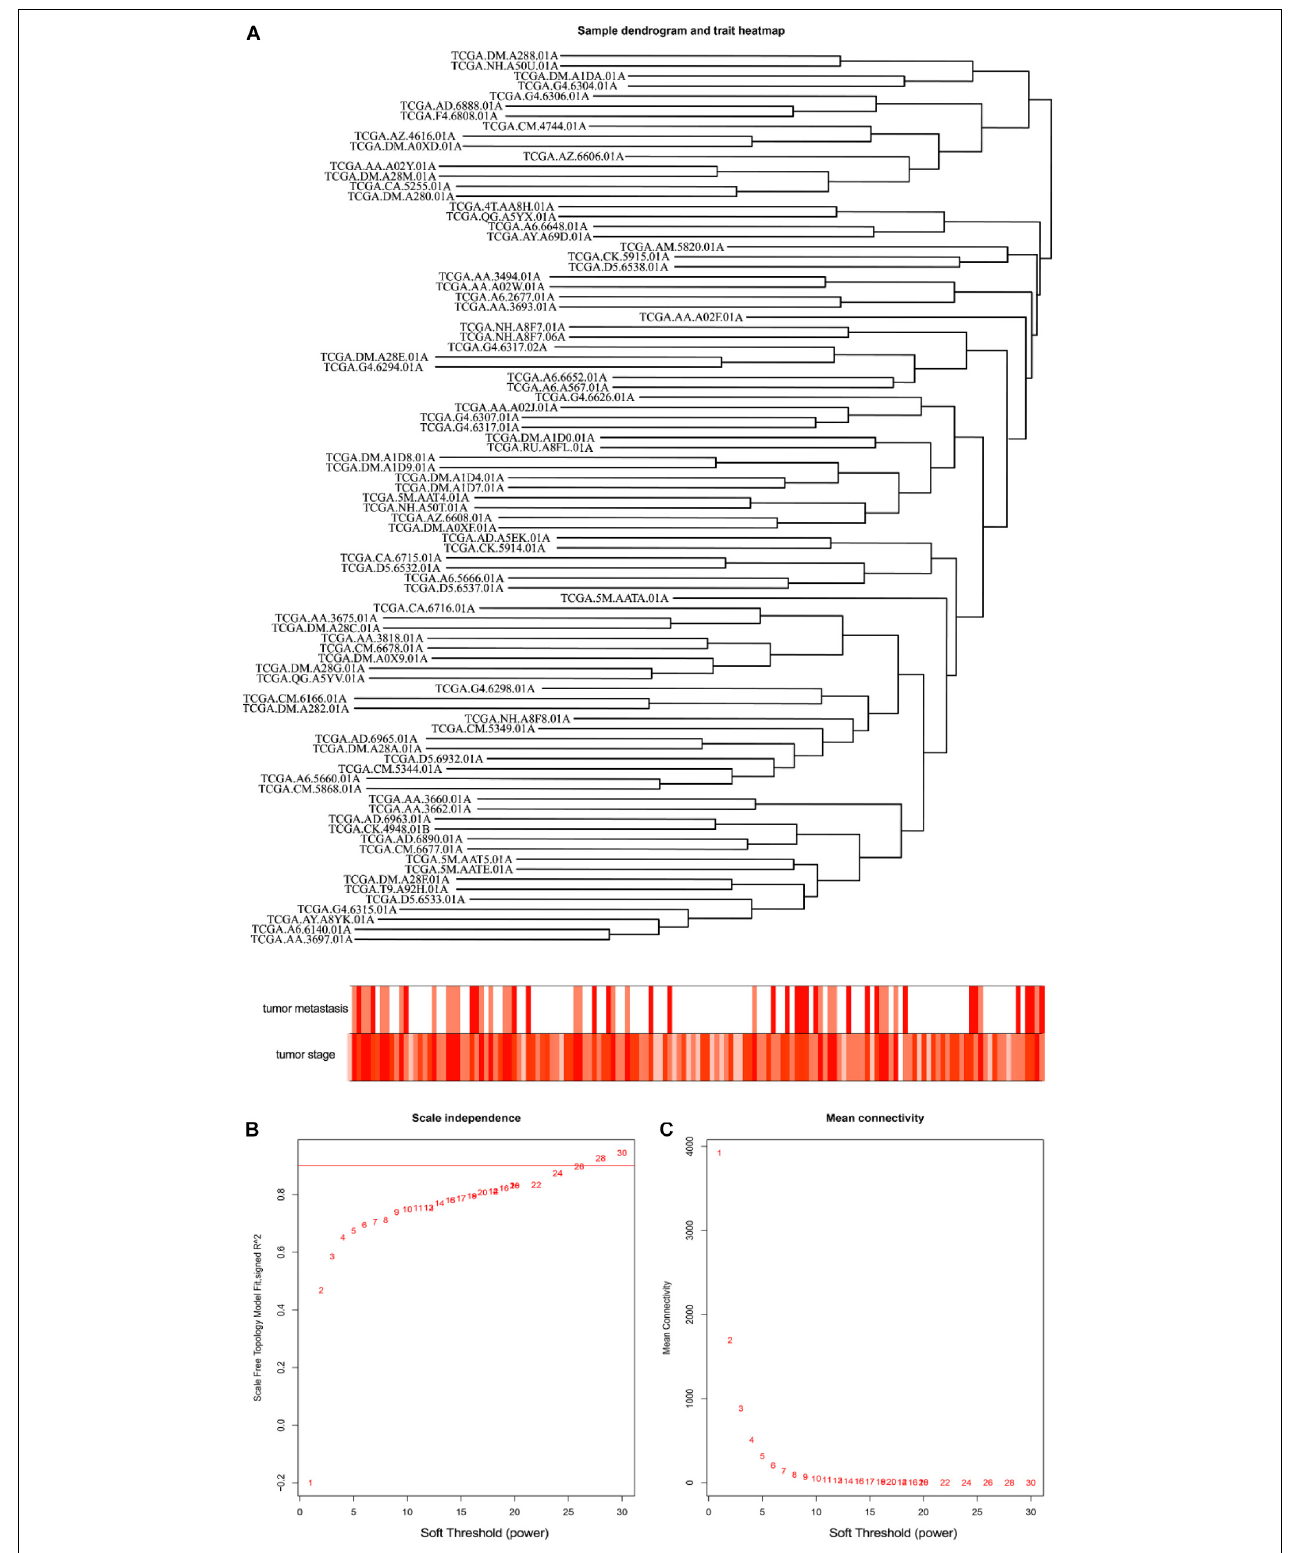
FIGURE 4 | Clustering of colorectal adenocarcinoma (COAD) for soft-thresholding power. (A) Clustering of COAD samples. (B) Calculating the scale-free fit index of soft-thresholding power. (C) Calculating the mean connectivity of soft-thresholding power.